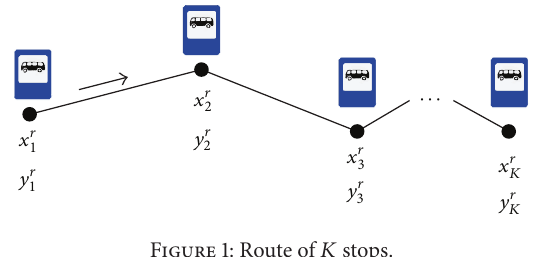
Figure 1: Route of 𝐾 stops. Table 1: Information on passenger traffic flow.